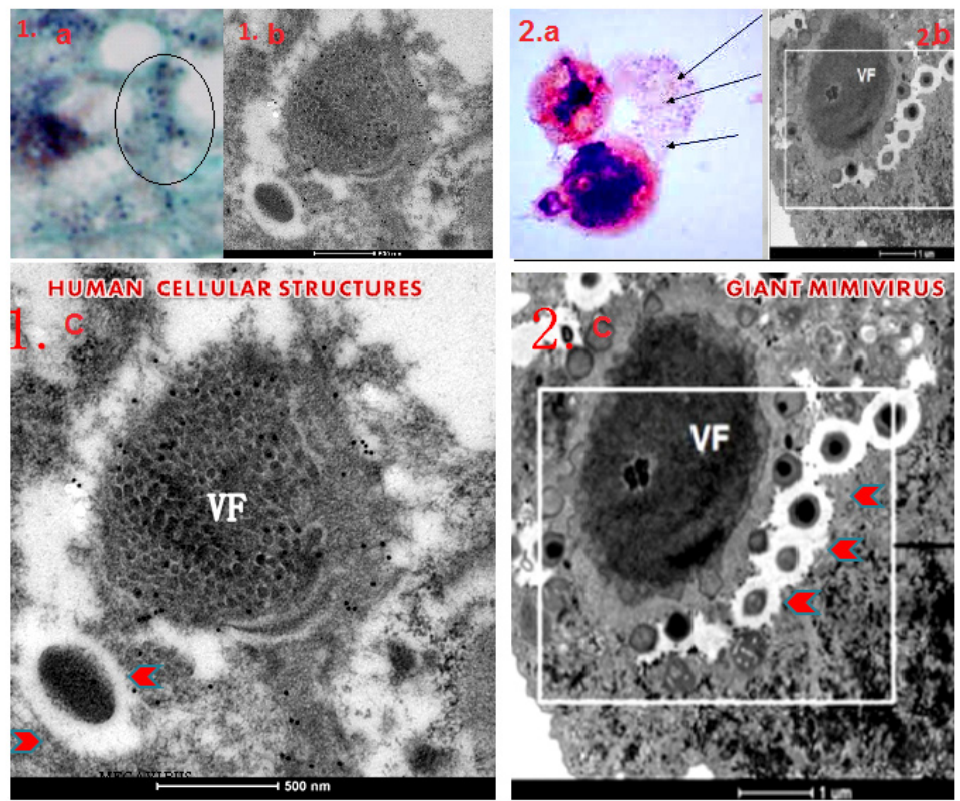
Figure 7. Representative micrograph of electron microscopy - comparative morphology. Electron microscopy (EM) of human liver tissues with the gram positive granules (black circle 1a) displayed Mimivirus-like structures at EM (1b). Similar gram positive blue granules in the amoeba (2a) are Mimiviruses (2b). Comparative morphological analysis revealed striking similarities between the human cellular structures (1c) with amoebas giant Mimiviruses (2c). Comparison of the two viral factories (VF) and the giant particles (red arrows) in the larger EM micrographs in section 1 and 2 show similarities between the